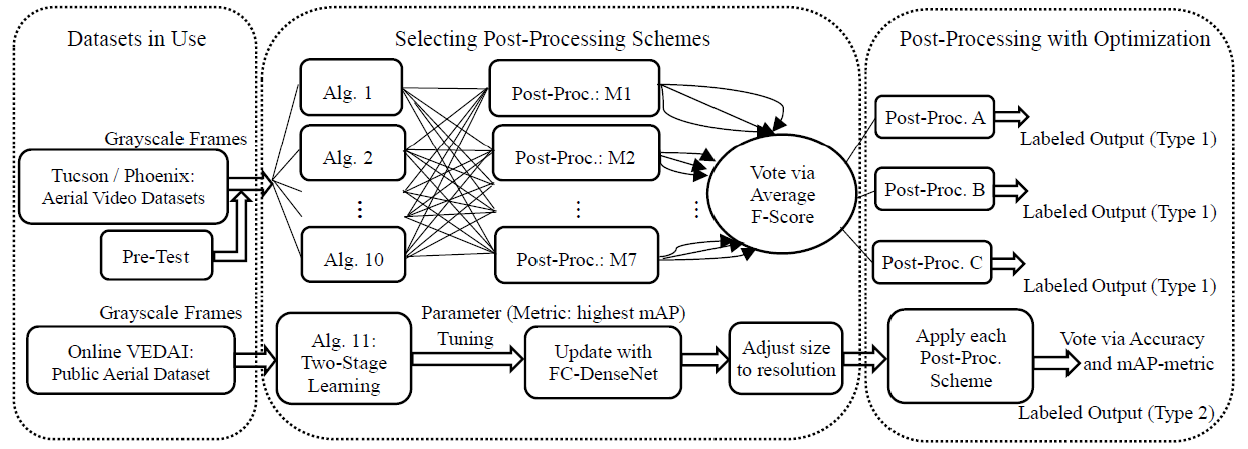
Figure 1. Pipeline of the proposed research study of small object detection. Labeled outputs of Type 1 are detection results of using ten feature extraction algorithms followed by each of the seven post ‐ processing schemes. Labeled outputs of Type 2 correspond to an updated multi ‐ stage learning approach (FC ‐ DenseNet) with selected post ‐ processing schemes.